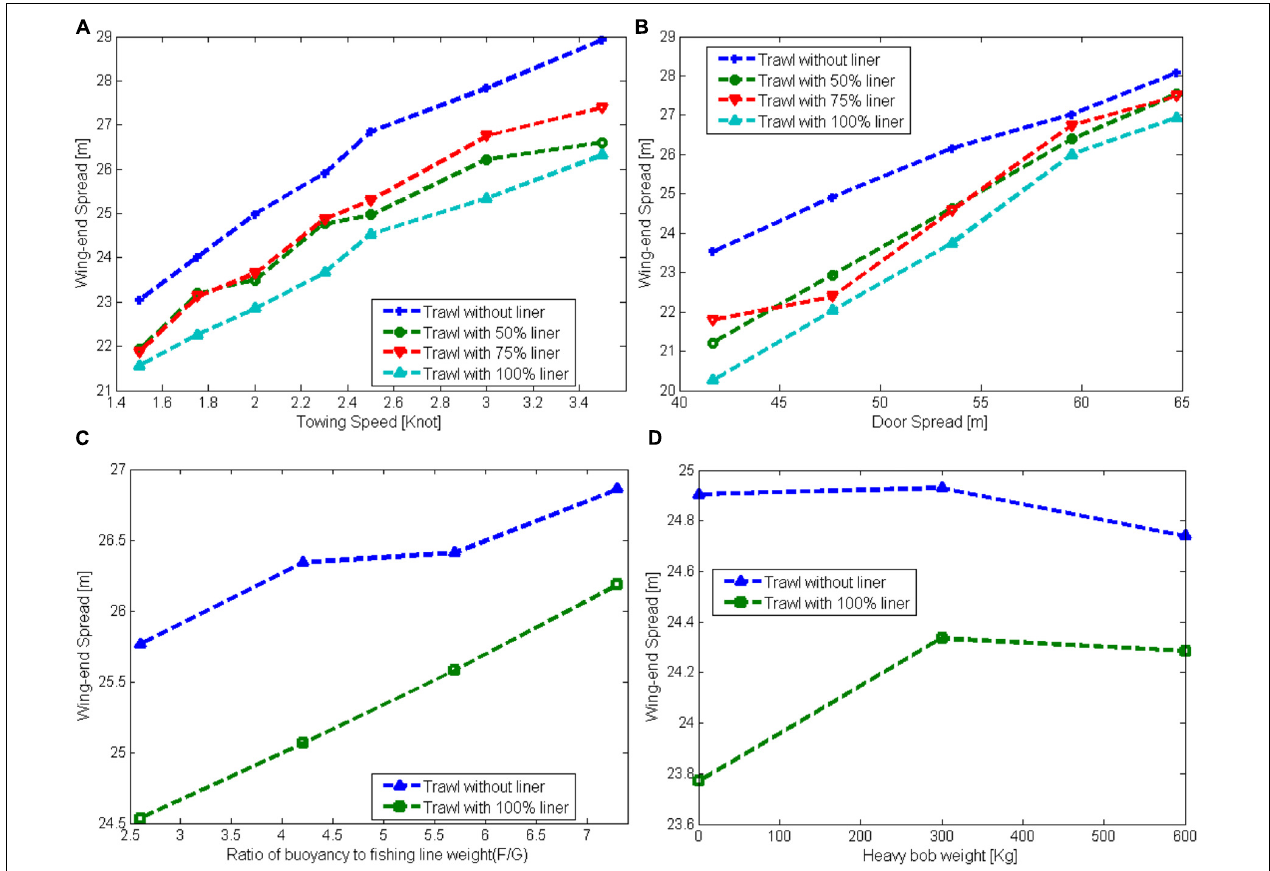
FIGURE 9 | The wing-end spread of different trawls about the (A) towing speed, (B) door spread, (C) ratio of buoyancy to F / G , and (D) heavy bob weight: current data estimated with 95% confidence intervals from the statistical